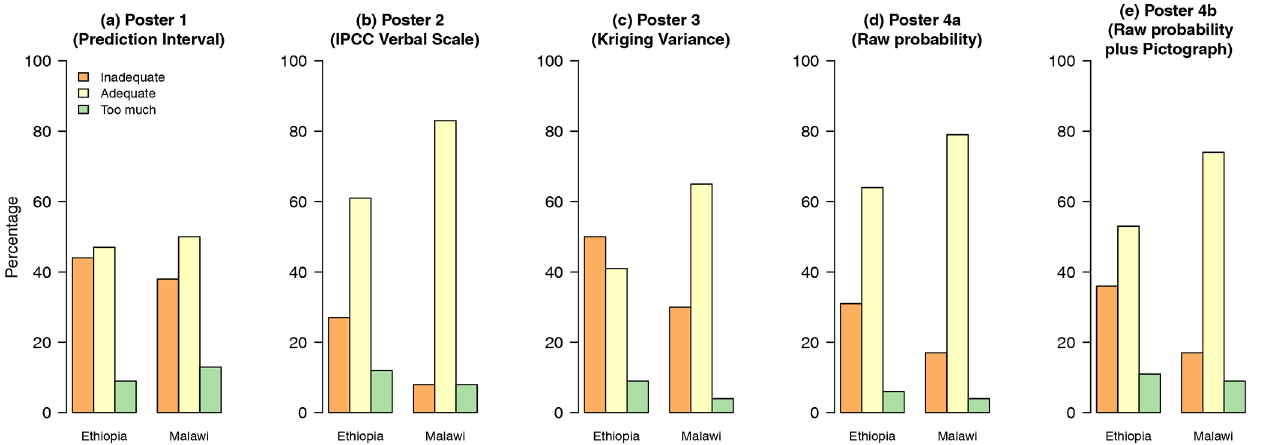
Figure 3. Bar charts showing how participants, when pooled according to the location of the meeting, responded to whether a method provided adequate information or not